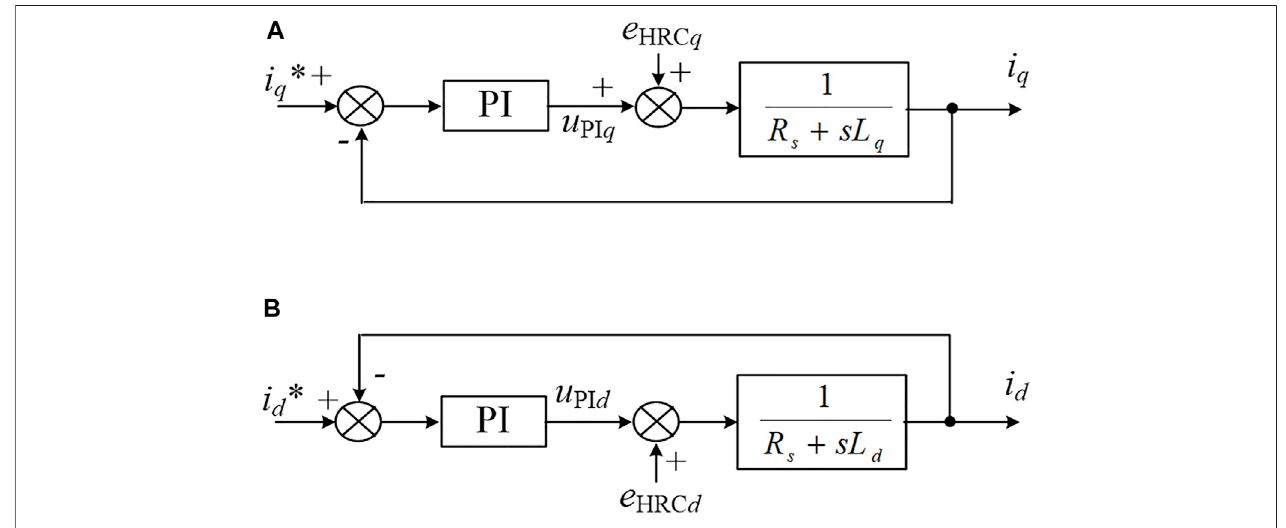
FIGURE 4 | Decoupled current control diagram of the PM machine with HRC. (A) q -axis; (B) d -axis.